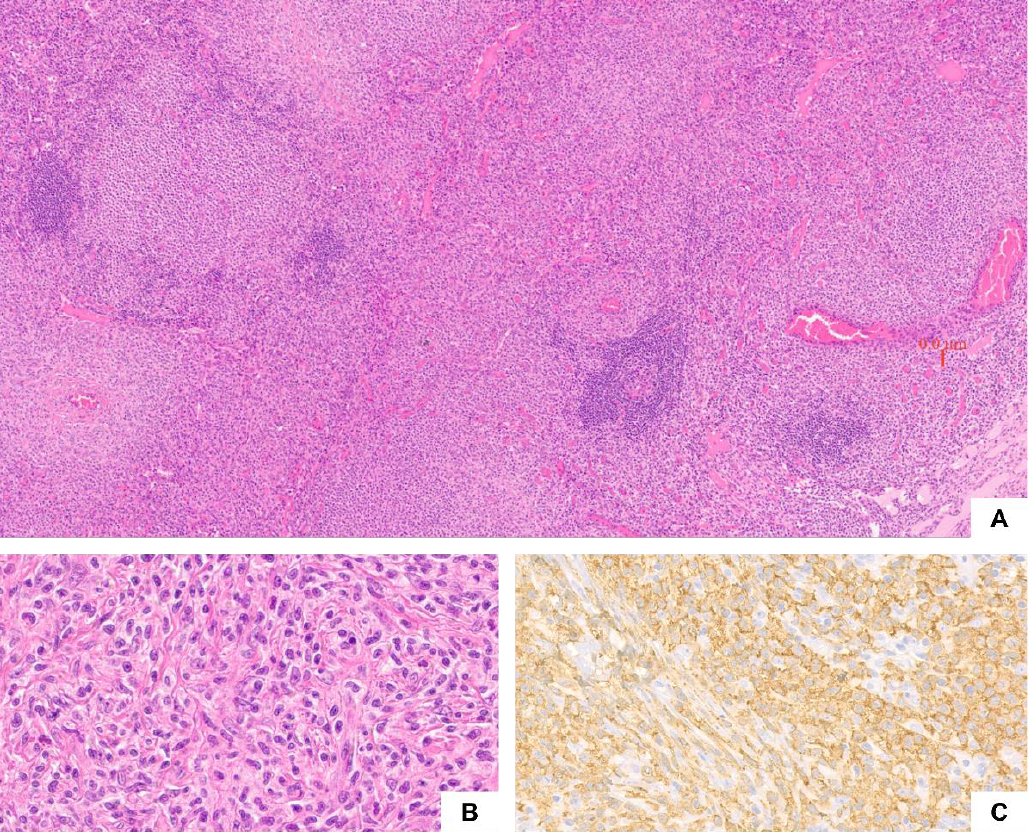
Figure 1. Case 1. Lymph node architecture was effaced by a diffuse, compact MC infiltrate, with few spared follicular structures. Slight collagen fibrosis, hyperplasia of small blood vessels and eosinophils were also seen ( A , hematoxylin an eosin, ×40). At higher magnification, MCs showed abundant pale cytoplasm and centrally located nuclei as well as spindle morphology ( B , hematoxylin and eosin, ×400). Immunohistochemically, MCs exhibited diffuse CD117 positivity ( C , ×400).